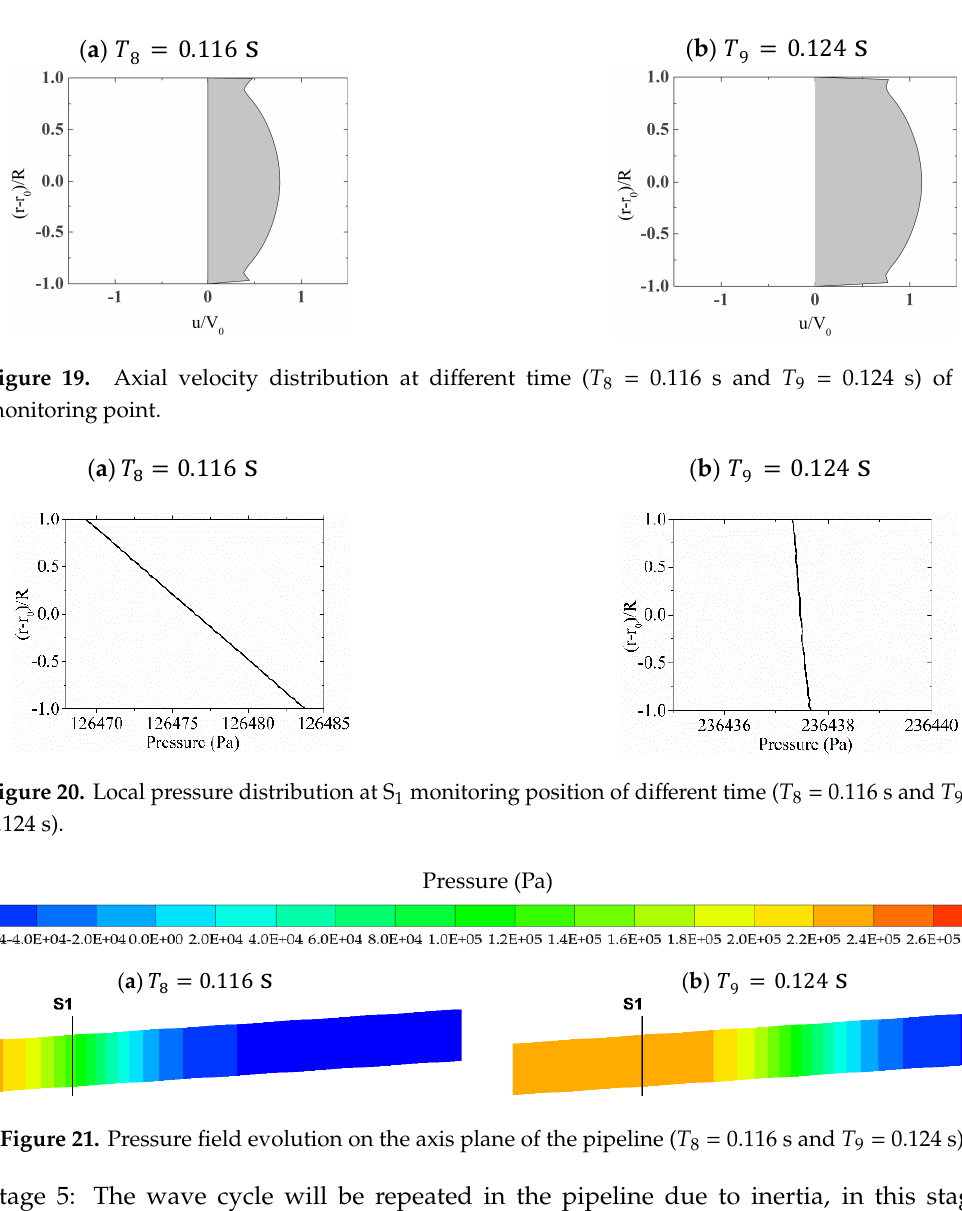
Figure 22. Axial velocity distribution at different time ( 𝑇 10 = 0.148 s and 𝑇 11 = 0.164 s ) of the S1 monitoring point.